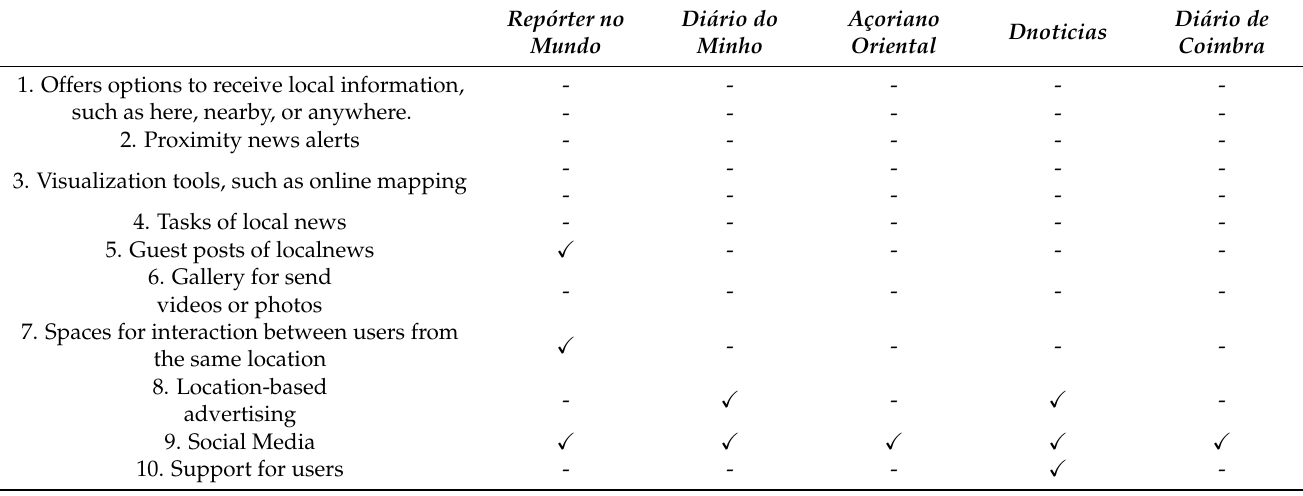
Table 4. The criteria met in the applications considered in this study. Rep ó rter no Di á rio